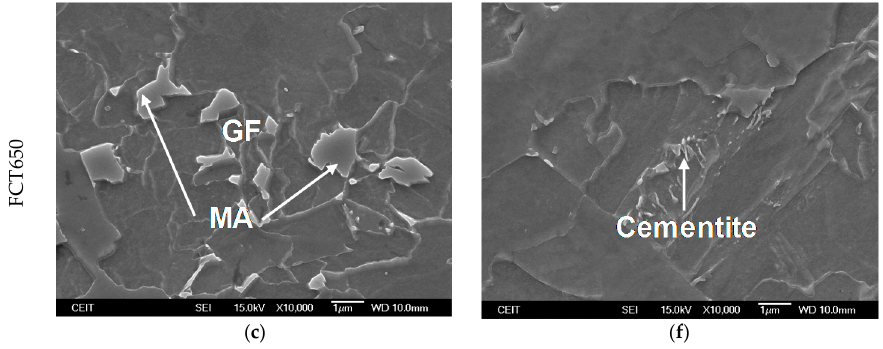
Figure 6. FEGSEM micrographs (higher magnifications) corresponding to every Fast Cooling Temperature and both ( a – c ) FCT and ( d – f ) FCT-HT samples: ( a , d ) FCT790, ( b , e ) FCT720 and ( c , f ) FCT650.